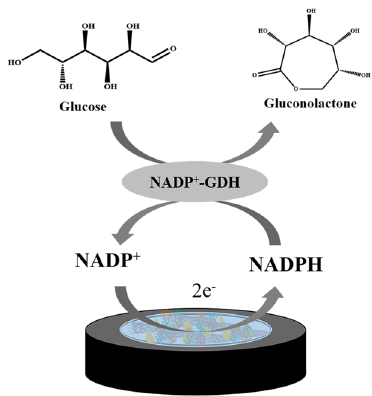
Figure 4. ( A ) CVs of the NF/GDH/IL/mPEG-fMWCNTs in 50 mM PBS at different pH values (from left to right): 4.0, 5.0, 6.0, 7.0 8.0 and 9.0, respectively. ( B ) Plot of peak current ratios versus pH values. ( C ) Plot of formal potential E o ′ versus pH values. versus Ag/AgCl. scan rate of 0.05 V s − 1 , 25 ± 1 °C.